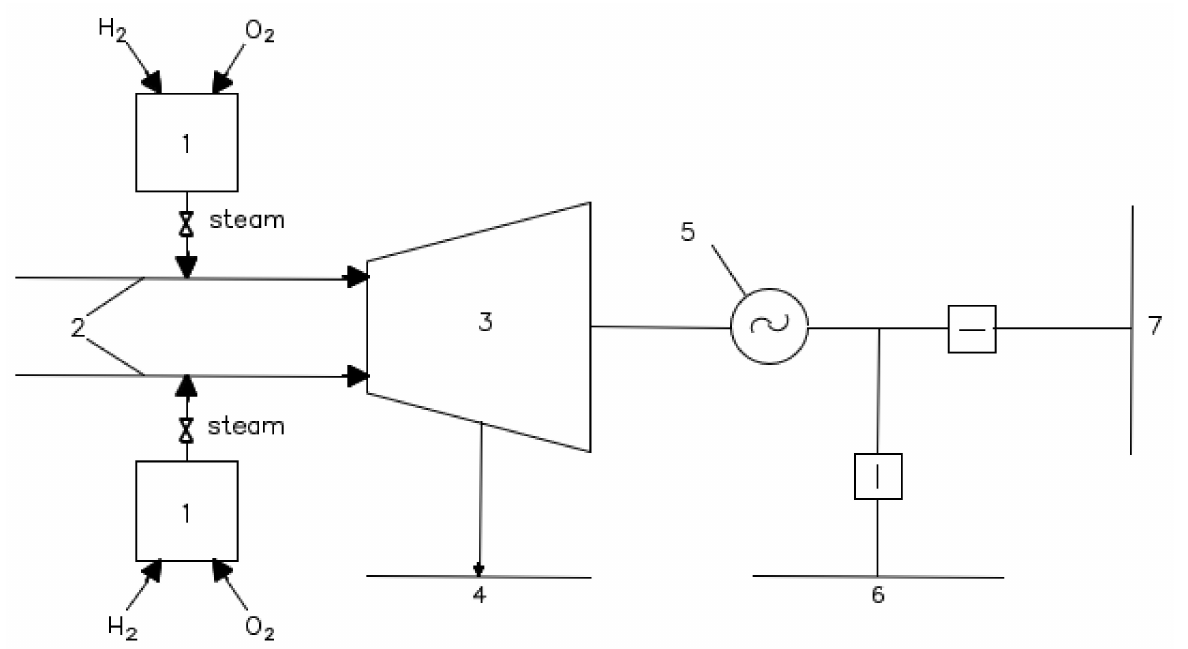
Figure 10. Diagram of the connection of the HOSG to the steam turbine of a Combined-Cycle Power Unit [61]. 1, hydrogen-oxygen steam generator; 2, steam lines from the boiler; 3, steam turbine; 4, house steam header; 5, generator; 6, electric self-service line; 7, electric power distribution